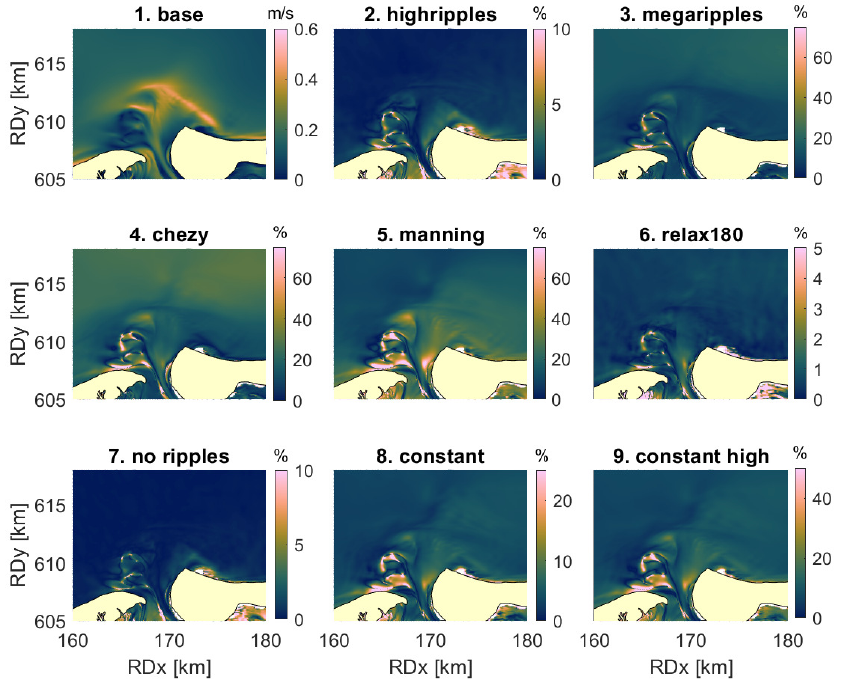
Figure 9. Mean depth-averaged current velocity u c (m/s) of the base scenario during the storm (1), and mean absolute relative difference in u c of all other scenarios with the base scenario during the storm